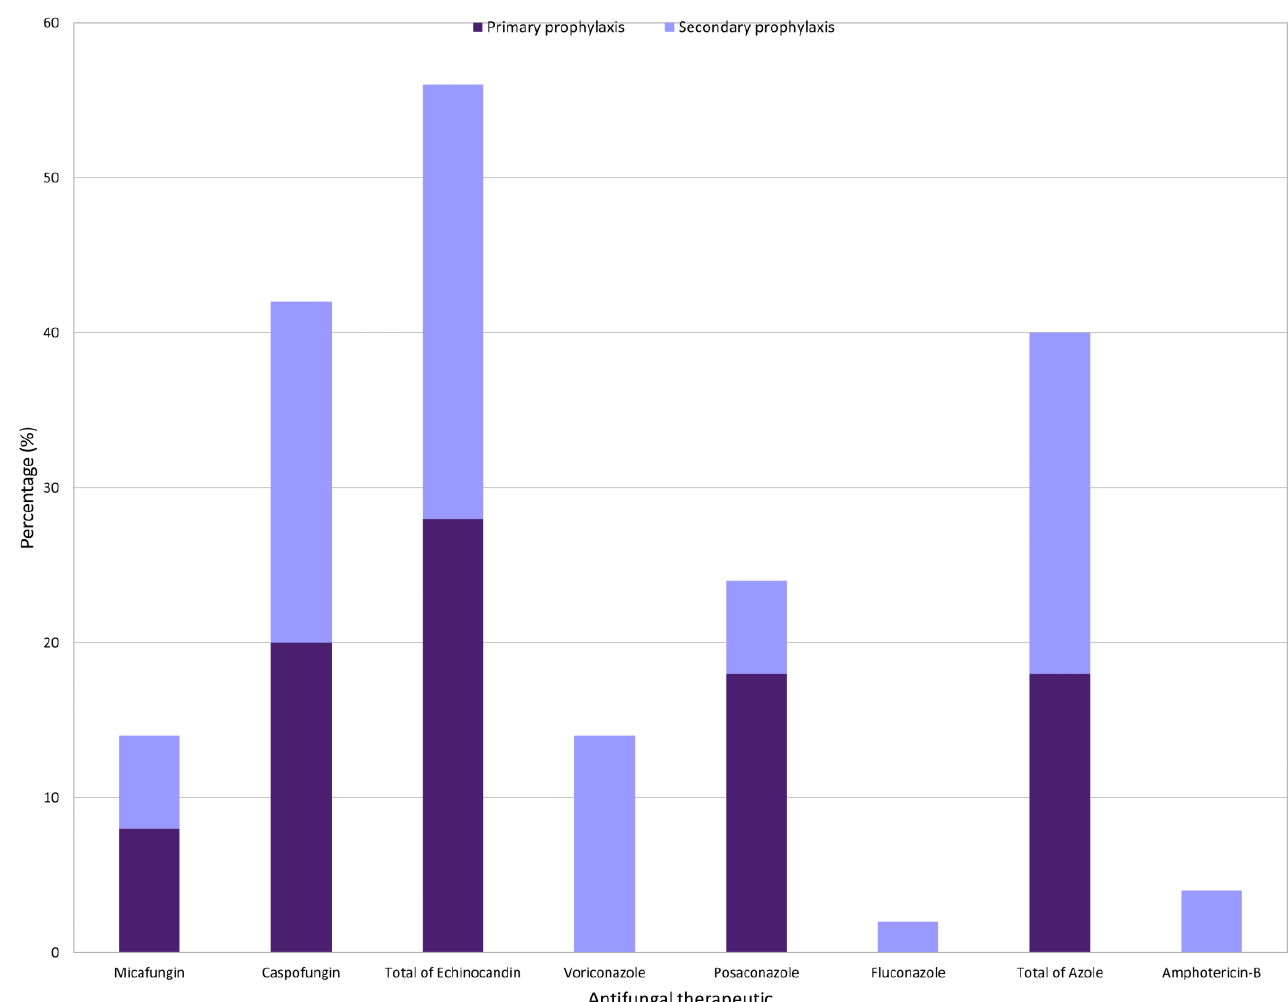
Figure 1. Overview of antifungal prophylaxis in 50 HCT procedure among 308 a-HCT patients. Among the eighteen patients with IFIs, only one patient received primary prophylaxis and another one received secondary prophylaxis. In the first case, the patient received posaconazole and finally presented trichodermosis 7 months post-a-HCT. Posaconazole spectrum does not cover this type of fungal organism. In the other case, the patient had a prior history of proven Aspergillus flavus infection 3 years before a-HCT, treated by 3 mg/kg/day of liposomal amphotericin B (L-AmB). He then received a prophylactic dose of 10 mg/kg/week of L-AmB. However, despite the action of L-AmB on molds, the patient developed two probable aspergillosis, 3 and 6 months